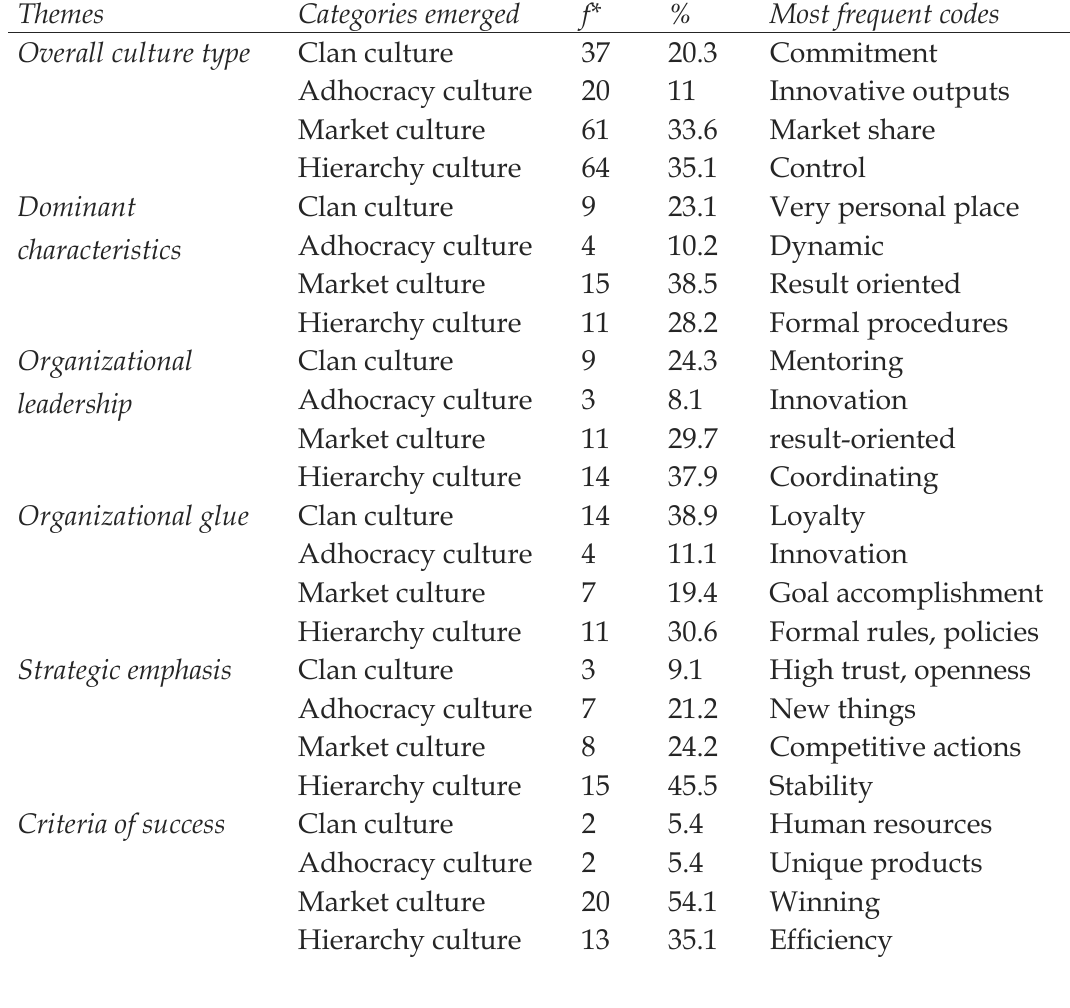
Students’ views on organizational culture in Turkish universities